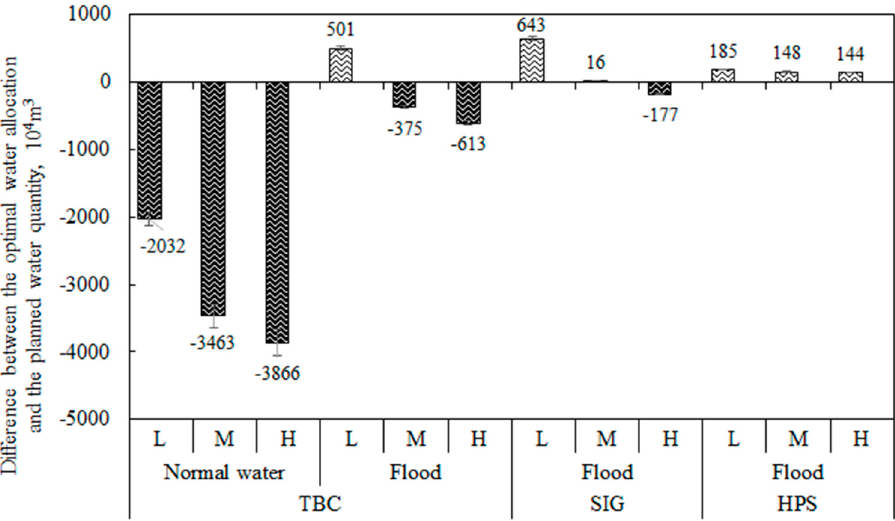
Figure 4. The reduction of the optimal water allocation compared with the planned water quantity of different water diversion resources in the water intakes of the Momoge National Nature Reserve (MNNR) under different flow levels (Negative values indicate decrease, and positive values indicate increase).